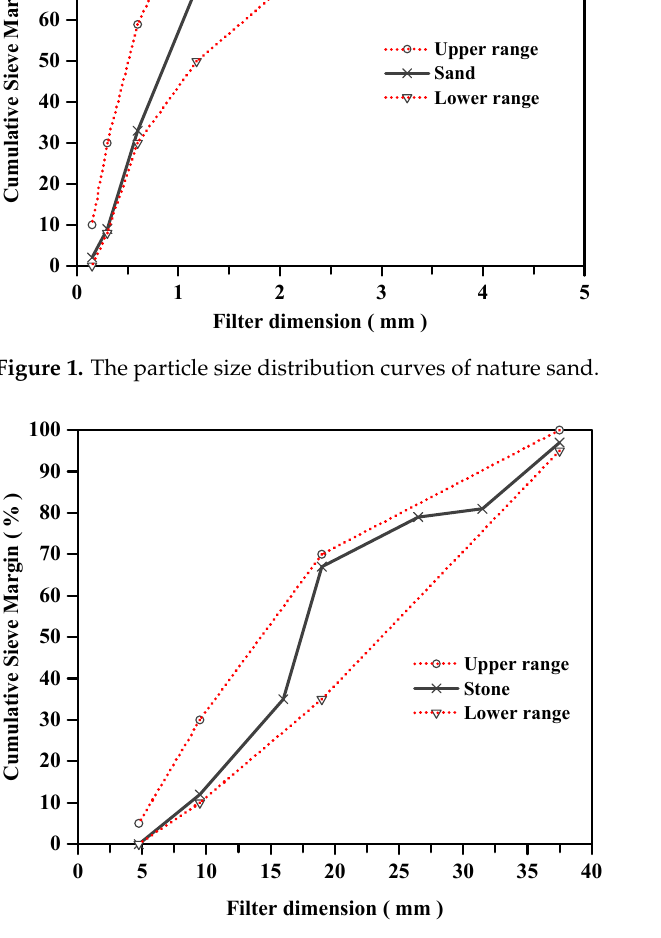
Figure 2. The particle size distribution curves of nature stone.